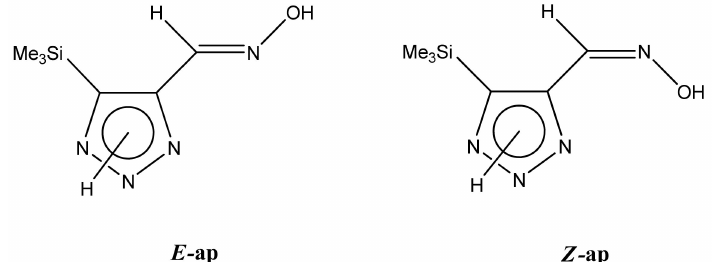
Scheme 17. Tautomeric equilibrium of 1,2,3-triazole-5-carbaldehyde oximes. The 1 H NMR spectra of compounds 29 – 31 , show broad OH and NH signals in the regions of 11 and 15 ppm, respectively. The carbon signals in the 13 C NMR spectra are also broadened, which indicates the existence of a prototropic exchange process. The assignment of carbon signals was made using two-dimensional { 1 H- 13 C} HMBC NMR spectra. Cross-peaks of methyl protons with the carbon atom in 4-(trimethylsilyl)-1,2,3-triazole-5-carbaldehyde oxime ( 29 ) are observed at 132.1 ppm (C-4), whereas the cross-peaks of the CH = N proton with carbon atoms are at 132.1 ppm (C-4) and 146.6 ppm (C-5) (Table 4). The orientation of the oxime fragment is defined from the carbon spectrum 13 C(H) without proton decoupling. The constant values 1 J C6-H in the 13 C NMR spectra of 29 – 31 are 164 – 166 Hz, which indicates the existence of the molecules in the form of the E -isomer (Scheme 18), as shown in [119,120].